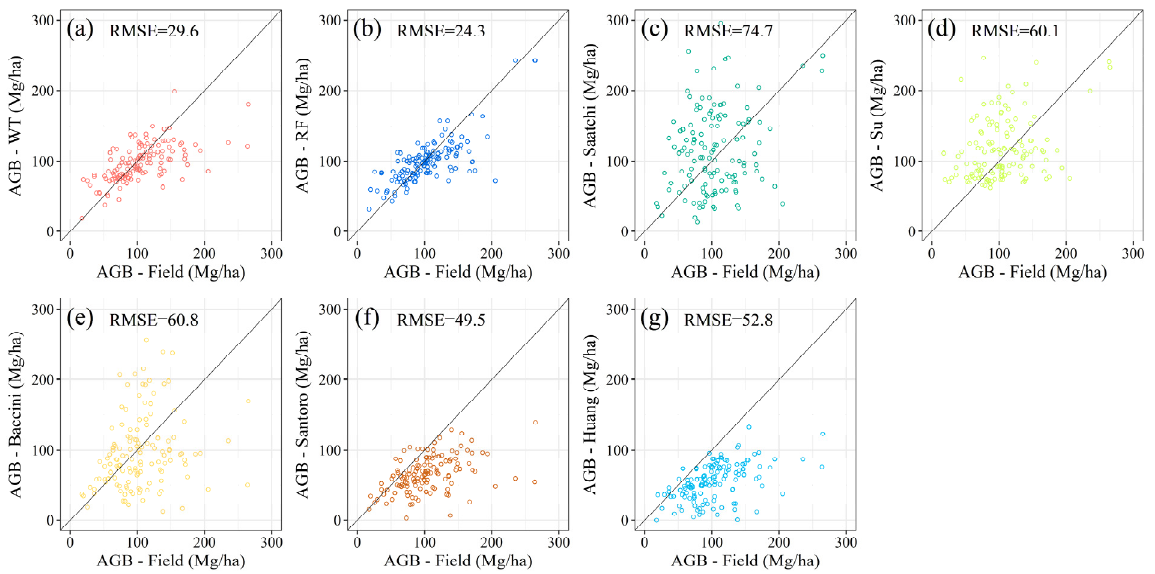
Figure 4. Scatterplots of the validated field AGB ( x -axis) and estimated AGB ( y -axis) of the ( a ) WT and ( b ) RF approaches and the ( c ) Saatchi, ( d ) Su, ( e ) Baccini, ( f ) Santoro, and ( g ) Huang maps. The RMSE is given in Mg/ha.